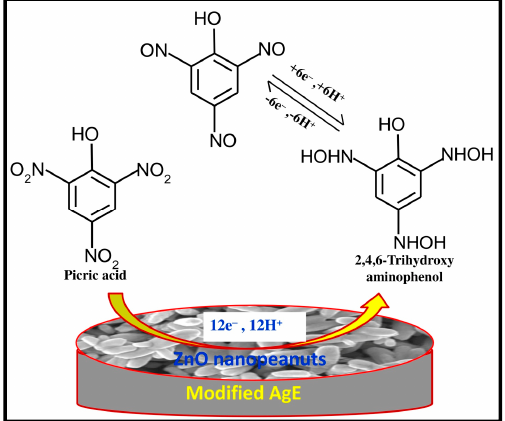
Figure 9. A sensing mechanism for picric acid sensing using modified AgE with ZnO nanopeanuts.